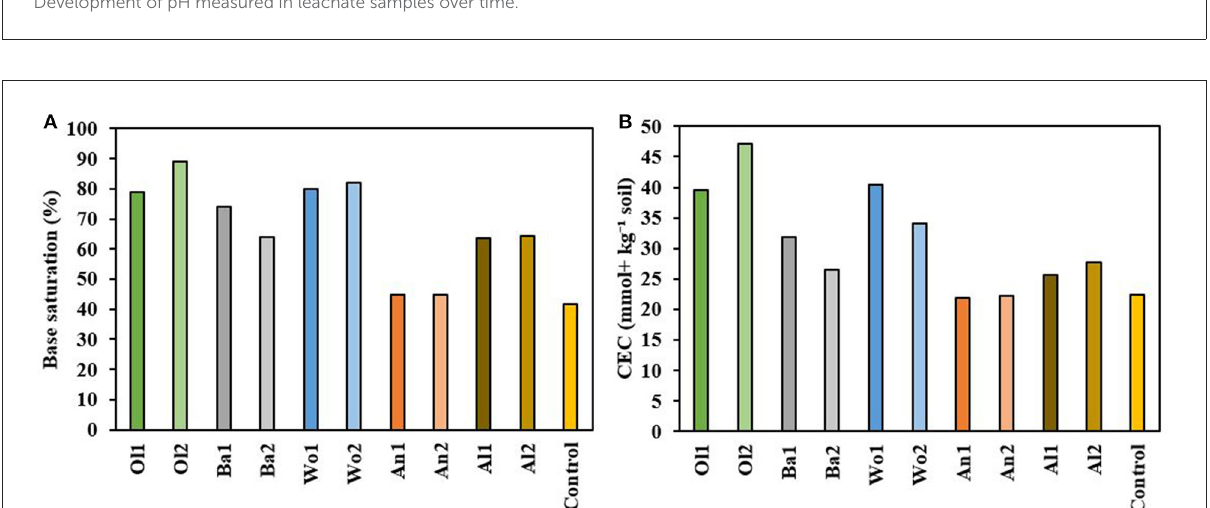
FIGURE4 (A) Soil base saturation (%) measured at the end of the experiment. (B) Soil CEC (mmol + kg − 1 soil) measured at the end of the experiment.